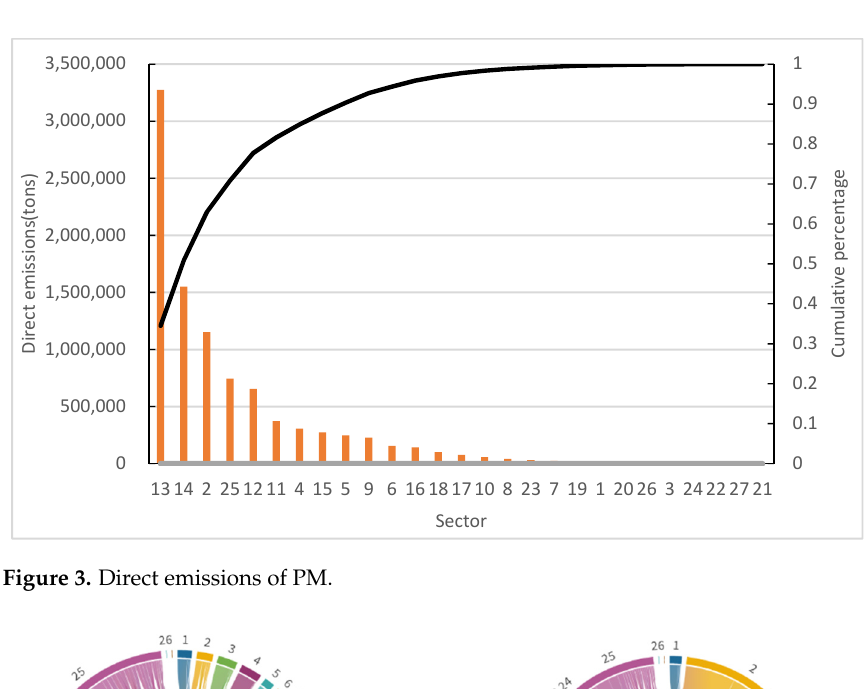
Figure 3. Direct emissions of PM.